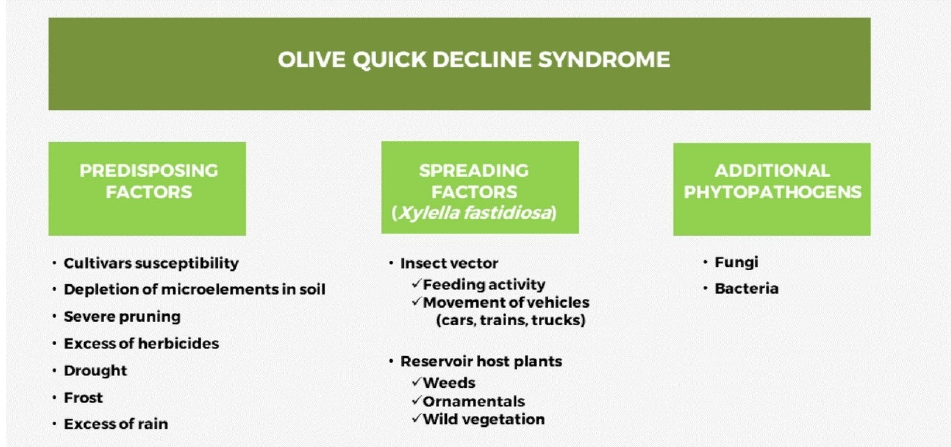
Figure 3. Synoptic panel that illustrates the predisposing factors, spreading factors, and occurrence of additional phytopathogens all involved in possibly causing the “olive quick decline syndrome” in Salento (Apulia, Italy).